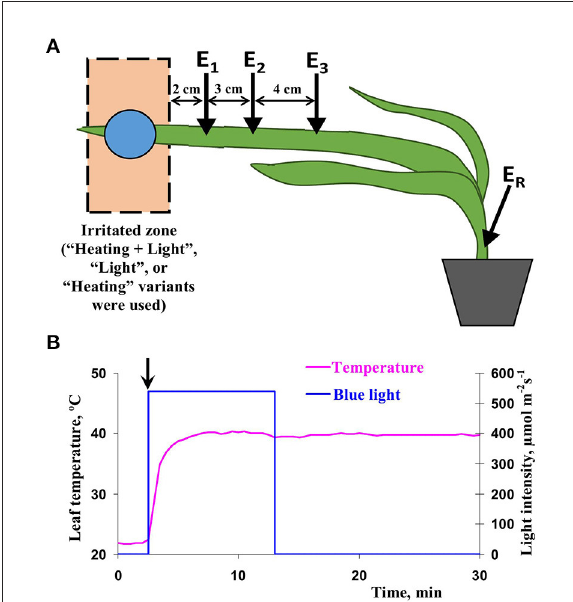
FIGURE1 (A) Scheme of localization of measuring (E 1 , E 2 , and E 3 ) and reference (E R ) surface electrodes on wheat plants. There were two levels of localization of electrodes: (i) E 1 was placed on 0cm from the irritated zone (on border of this zone), E 2 was placed on 2cm from the irritated zone, and E 3 was placed on 5cm from the irritated zone, and (ii) E 1 was placed on 2cm from the irritated zone, E 2 was placed on 5cm from the irritated zone, and E 3 was placed on 9cm from the irritated zone. E R was placed on the wheat stem (near the soil). Figure show the second variant of electrode localization and distance between measuring electrodes. Combination of the blue light (540 µ mol m − 2 s − 1 ) and the heating (40 ◦ C), which locally acted the top of the second wheat leaf, was used as the main irritation (“Heating + Light”). In separate experiments, only the blue light (“Light”) or only the heating (“Heating”) were used. (B) Dynamics of leaf temperature and intensity of blue light during the leaf irritation by the combination of heating and illumination. Initiation of irritation is marked by